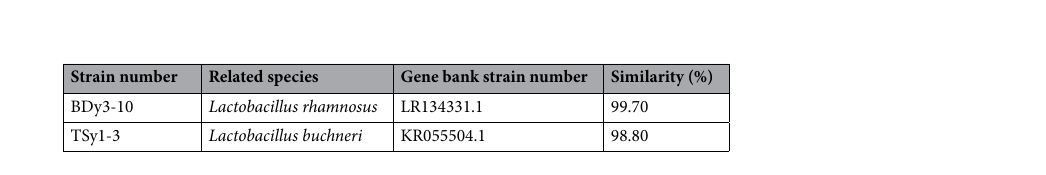
Table 5. BLAST alignment of 16S rRNA sequences of